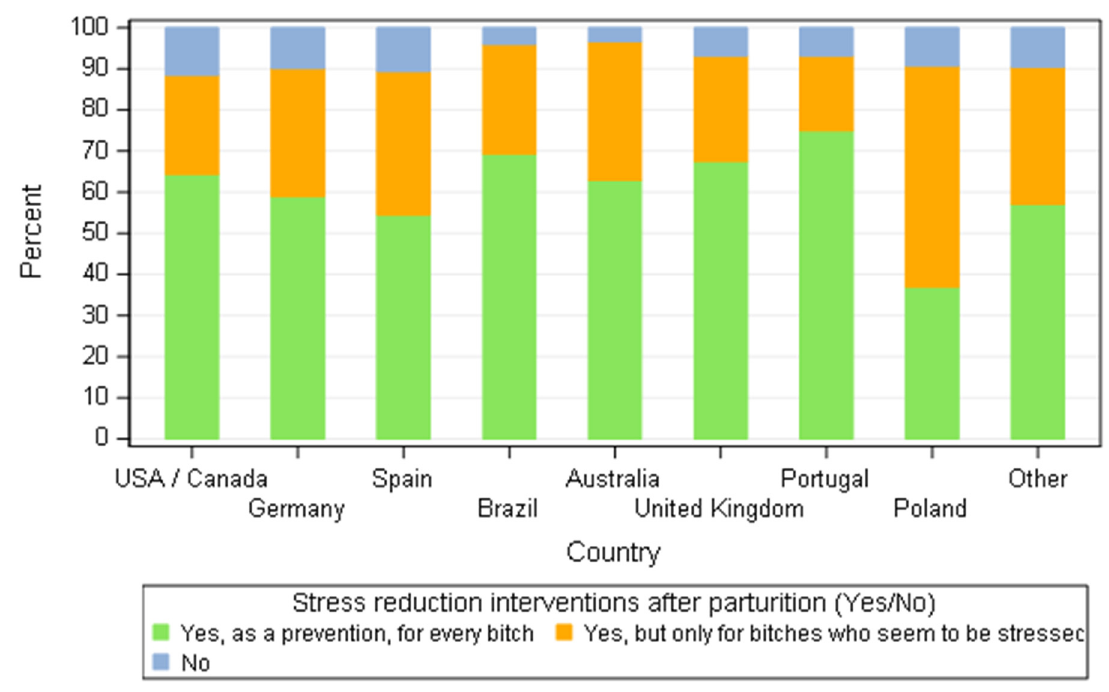
Figure 16. Distribution of responders that intervene to reduce stress after parturition by country—all responders ( n = 668).